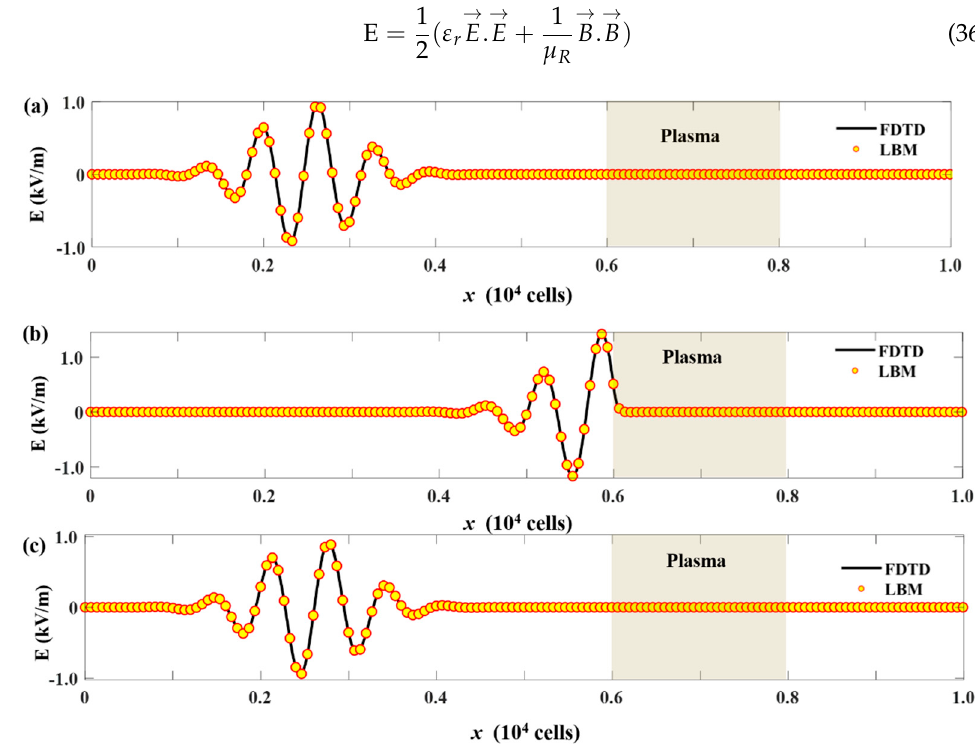
Figure 5. Simulation of a wave propagating in air and striking a plasma medium. The plasma has the properties of silver: ω p = 2000 THz, ϑ c = 50 THz. The propagating wave has a center frequency of 500 THz. ( a , b ) show electric field in the computational domain at different times ( a ) = 0 fs, ( b ) = 11 fs, and ( c ) = 21 fs. (Left side with film thickness of 1000 cells, right side with film thickness of 2000 cells).